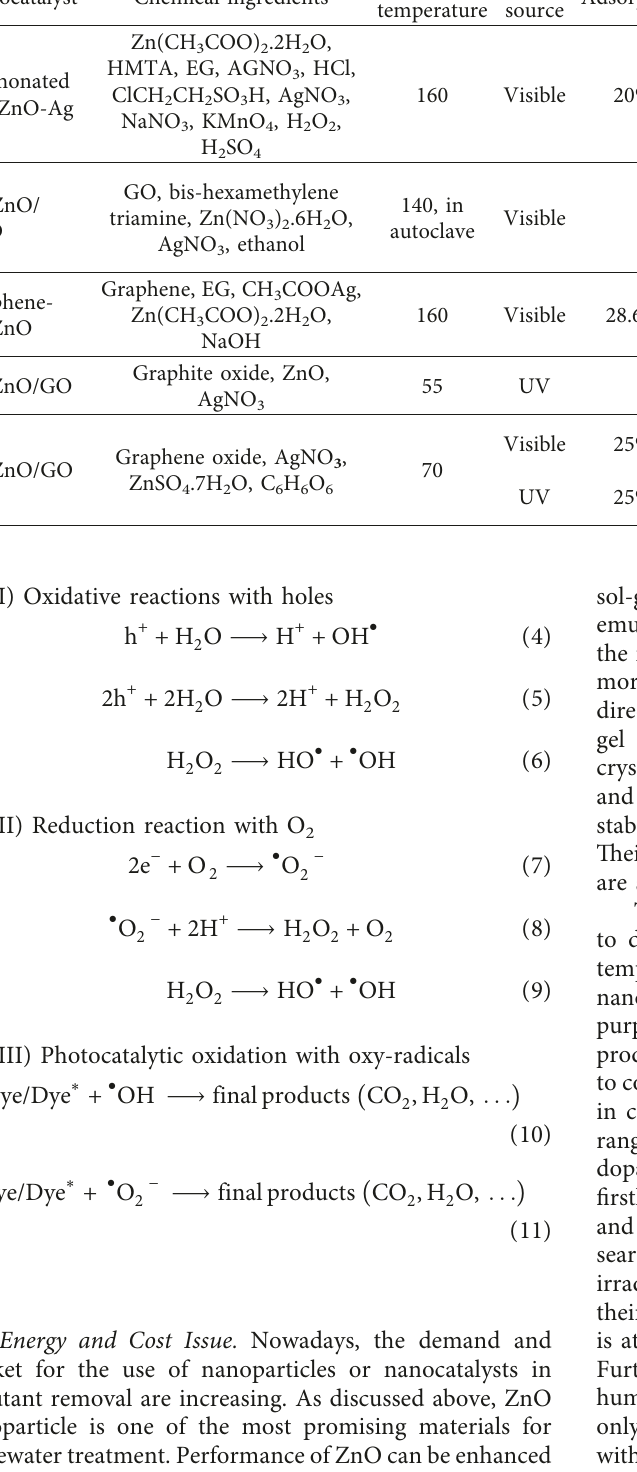
Table 2: Comparison between previous and current studies for MB removal using photocatalytic degradation.